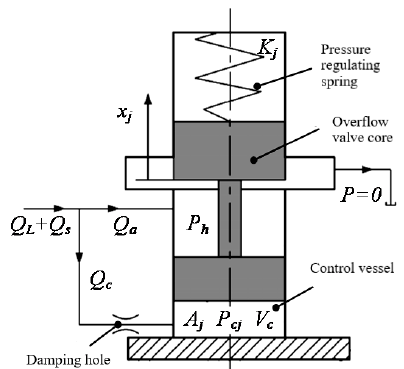
Figure 5. The principle of DBD type relief valve.